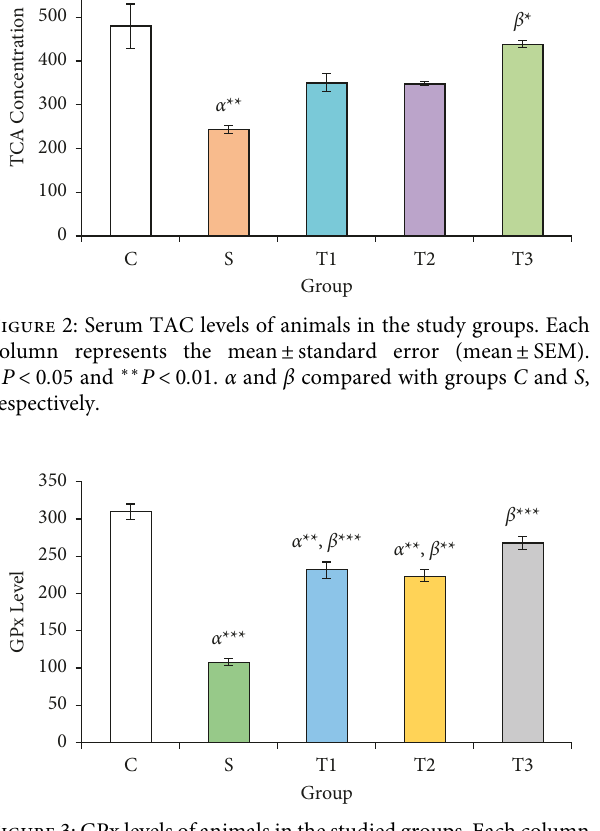
Figure 3: GPx levels of animals in the studied groups. Each column represents the mean ± standard error (Mean ± SEM). ∗∗ P < 0 . 01 and ∗∗∗ P < 0 . 001. α and β compared with groups C and S ,